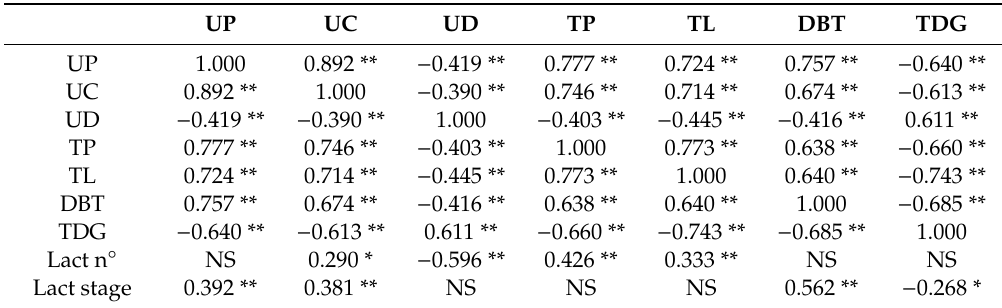
Table 2. Correlations between mammary measured conformation trait (cm), lactation number and lactation stage in